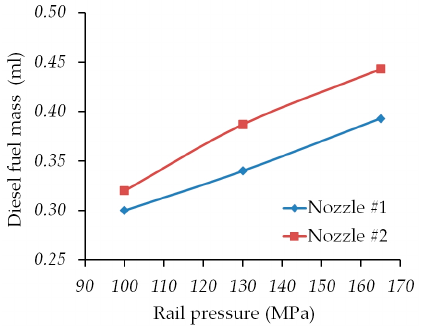
2 at different rail pressure (Figure 12) are plotted.